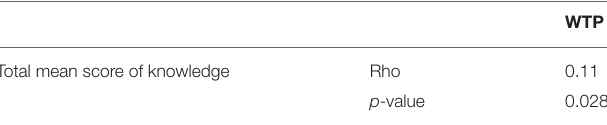
TABLE 5 | Factors associated with WTP for HPV vaccine among the participants ( n =